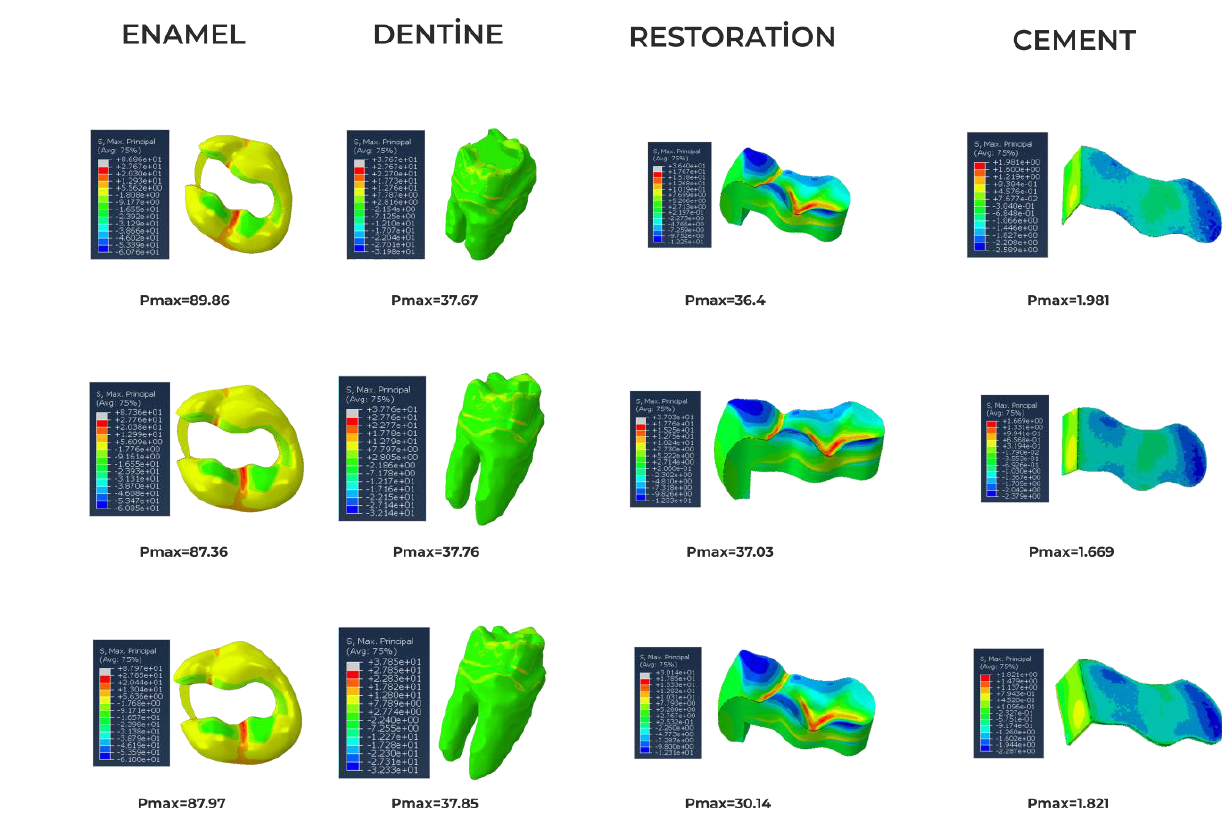
Figure 9. Maximum principal stress distribution in restorations applied with GI of different thick- nesses (50 GPa Young’s modulus of amalgam).